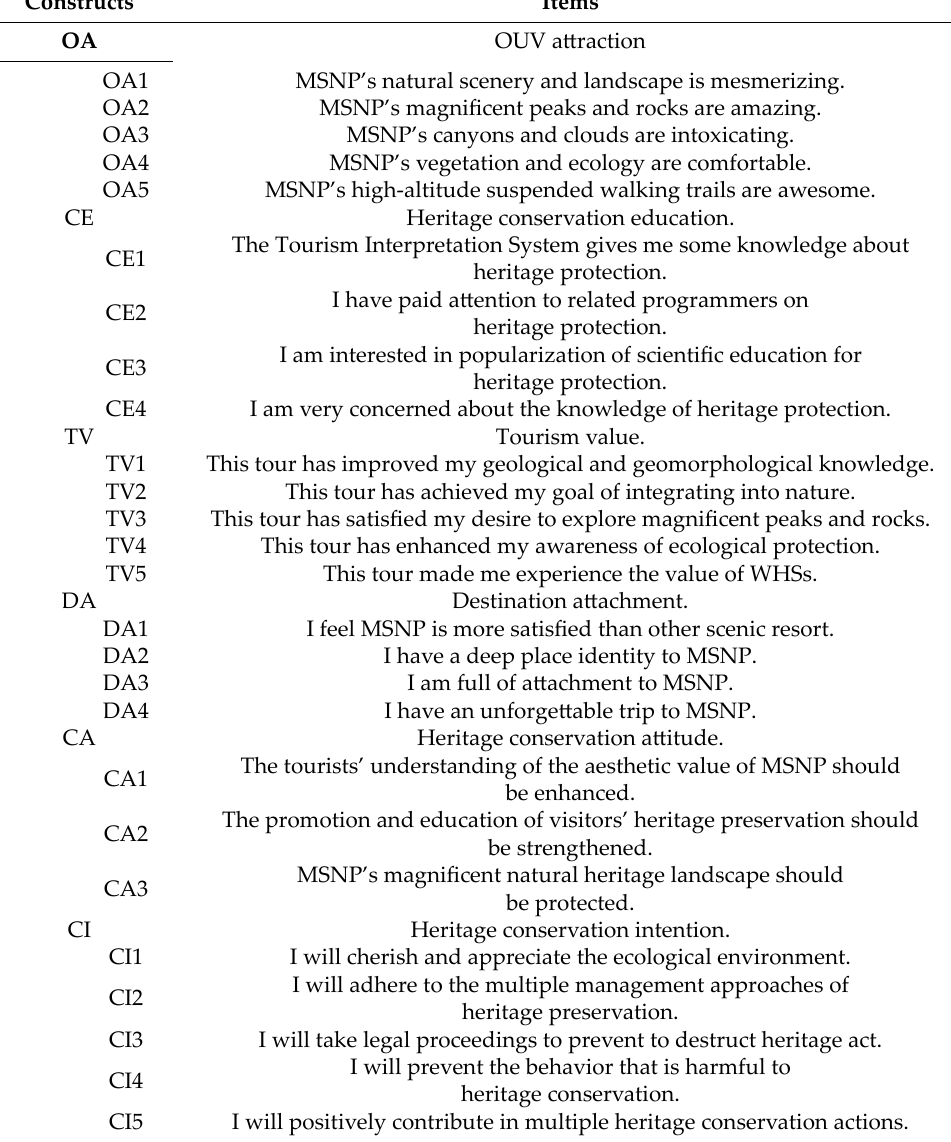
Table 1. Measurement